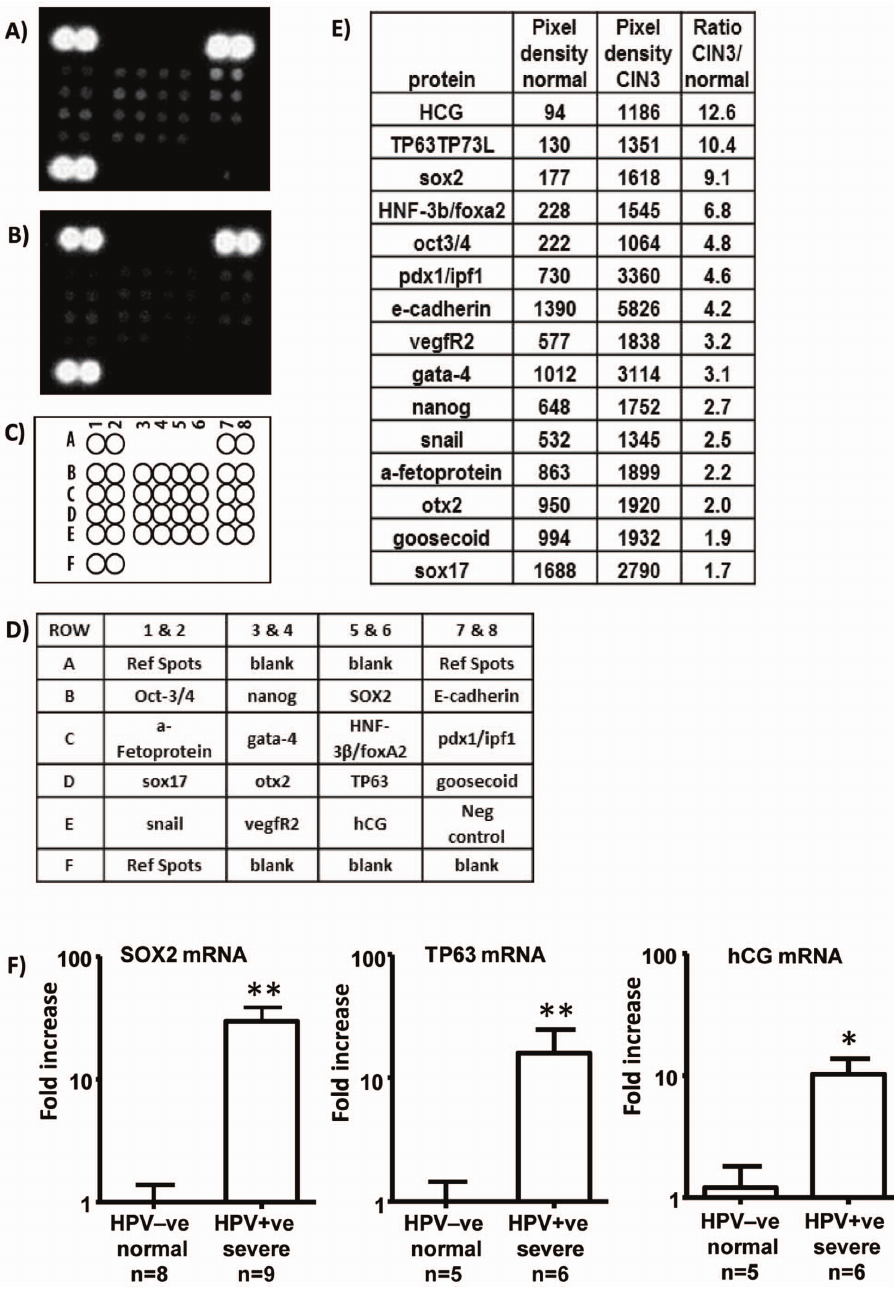
Fig. 2. Proteomic array detection of stem cell associated proteins in pooled aliquots from 9 HR- HPV + ve cervical samples from women with CIN3 (A) and 9 HPV –ve samples with normal cytology (B); (C & D) map and key for array spots; (E) average pixel density ranked by ratio of pooled CIN3:normal samples for each protein on the array; (F) sox2, TP63 and HCG mRNAs are upregulated in HPV + ve cervical samples with severe dyskaryosis compared to HPV–ve samples with normal morphology (* 5 p , 0.05, ** p , 0.01, Mann Whitney